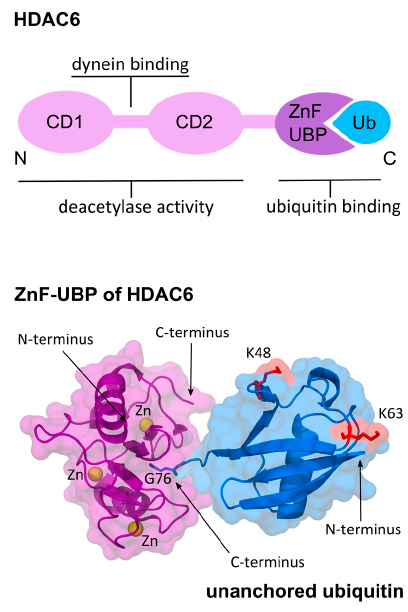
Figure 2. Functional domains of histone deacetylase 6 (HDAC6) and zinc finger ubiquitin ‐ binding domain (ZnF ‐ UBP) binding to ubiquitin (Ub) C ‐ terminus. Top : Functional domain organization of